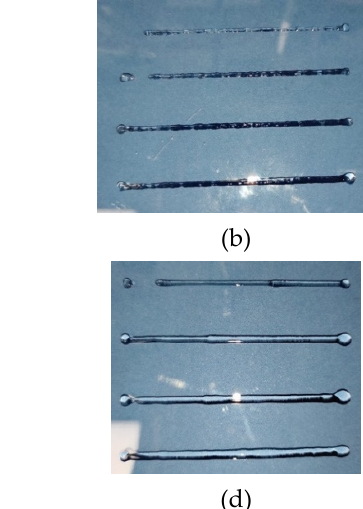
Figure 4. Snapshots of filaments printed at different extrusion temperatures and volumetric flow rates—( a ) 28 °C; ( b ) 32 °C; ( c ) 36 °C; ( d ) 40 °C—and at a fixed printing speed of 12 mm/s.